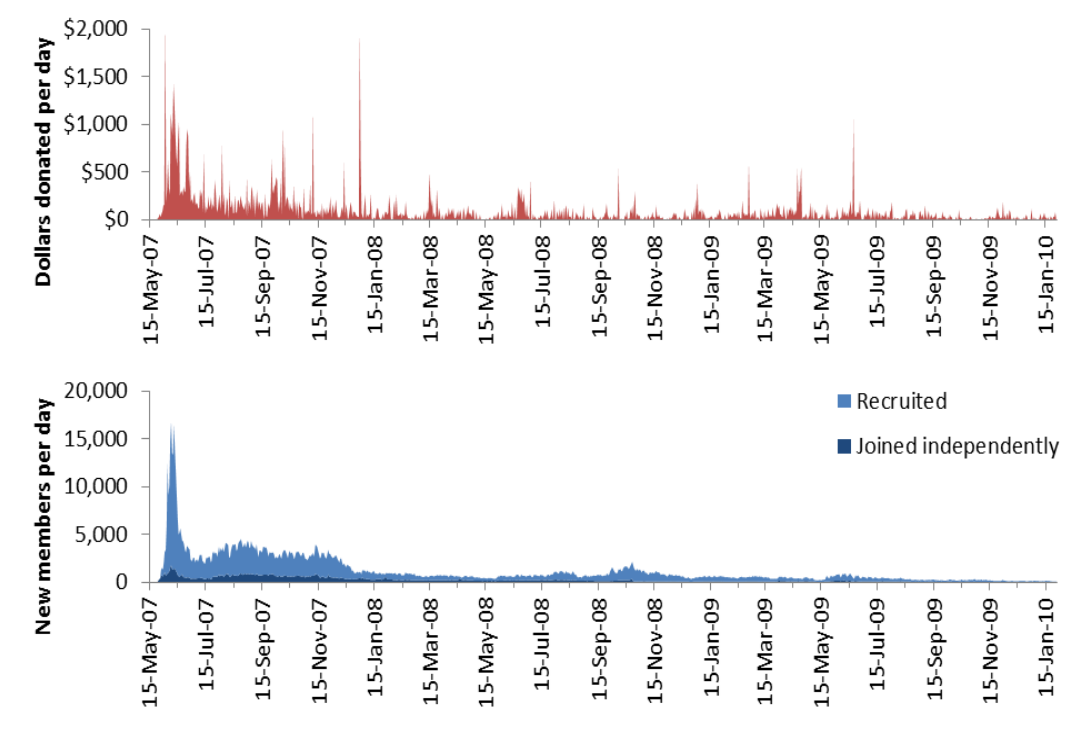
Figure 2: Changes in growth rates over time. Another look at the development of the Save Darfur Cause, presented here as changes in daily rates of ( A ) dollars donated and ( B ) new members (as opposed to cumulative dollars and members, as in Fig.